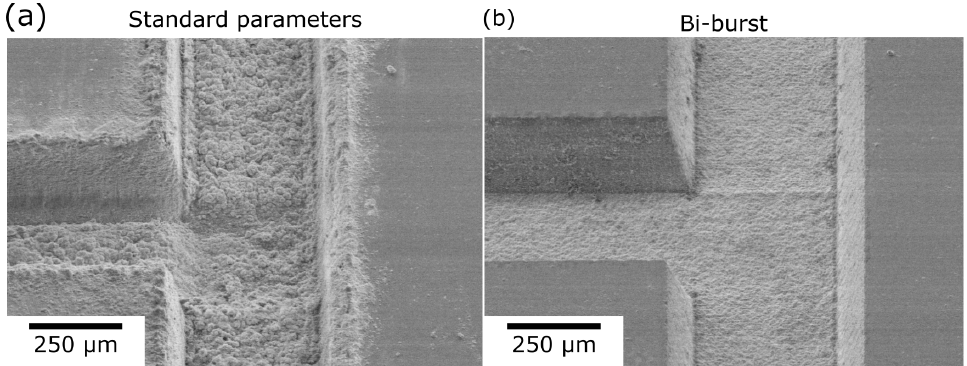
Figure 6. SEM images of channels produced using ( a ) standard fs laser and ( b ) bi-burst regime. Improvement of RMS from few µm to sub-500 nm is evident.